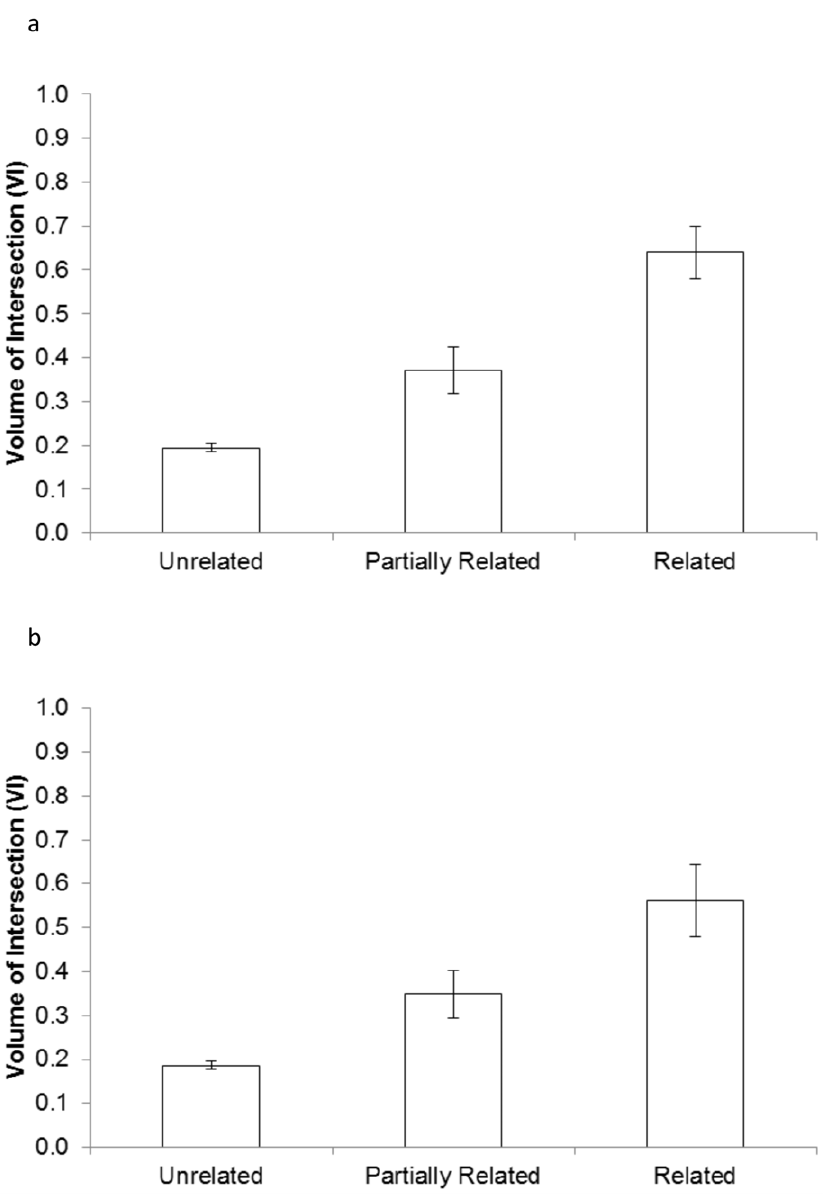
Figure 2. Charts detailing the average degree of overlap among deer in different categories of relatedness. Unrelated indicates R xy values between 0 and 0.25, partially related indicates R xy values between 0.26 and 0.5, and related indicates R xy values above 0.5. Figure 2a is generated from the dataset where each pair contains at least one adult (dataset adult ), and figure 2b is generated from the dataset using only deer- pairs from capture groups 1 and 2 (dataset capgroup ). Figure 2a. Figure 2b.